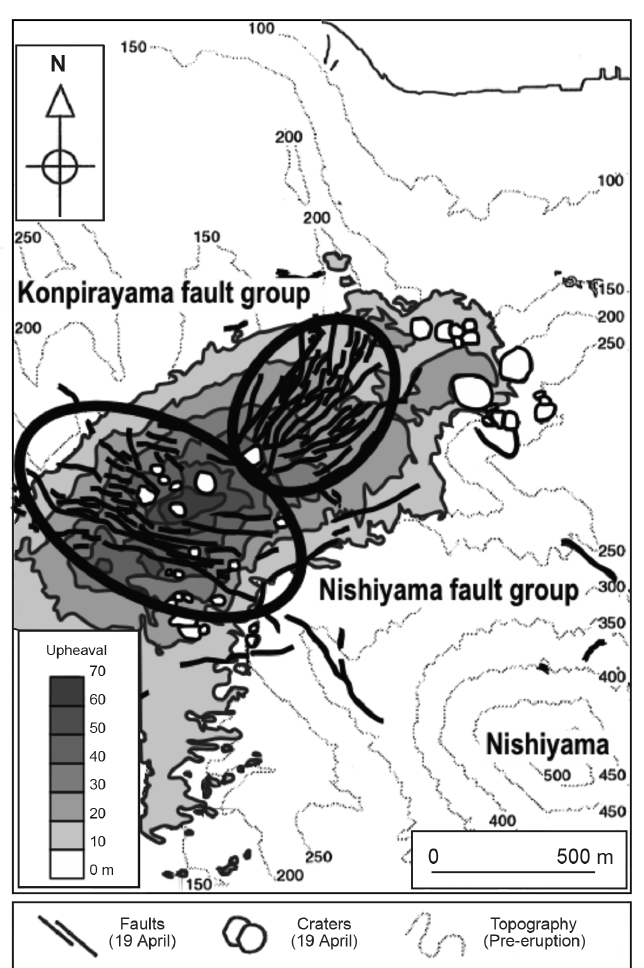
Fig. 2. Distribution of newly formed craters, faults, and a cryptodome (shaded part). The upheaval data of the cryptodome were measured on 26 April, 2000 (after unpublished data of Public Works Research Institute). Dis- tribution of the faults and craters was investigated on 19 April, 2000 (modified after Miura and Niida,